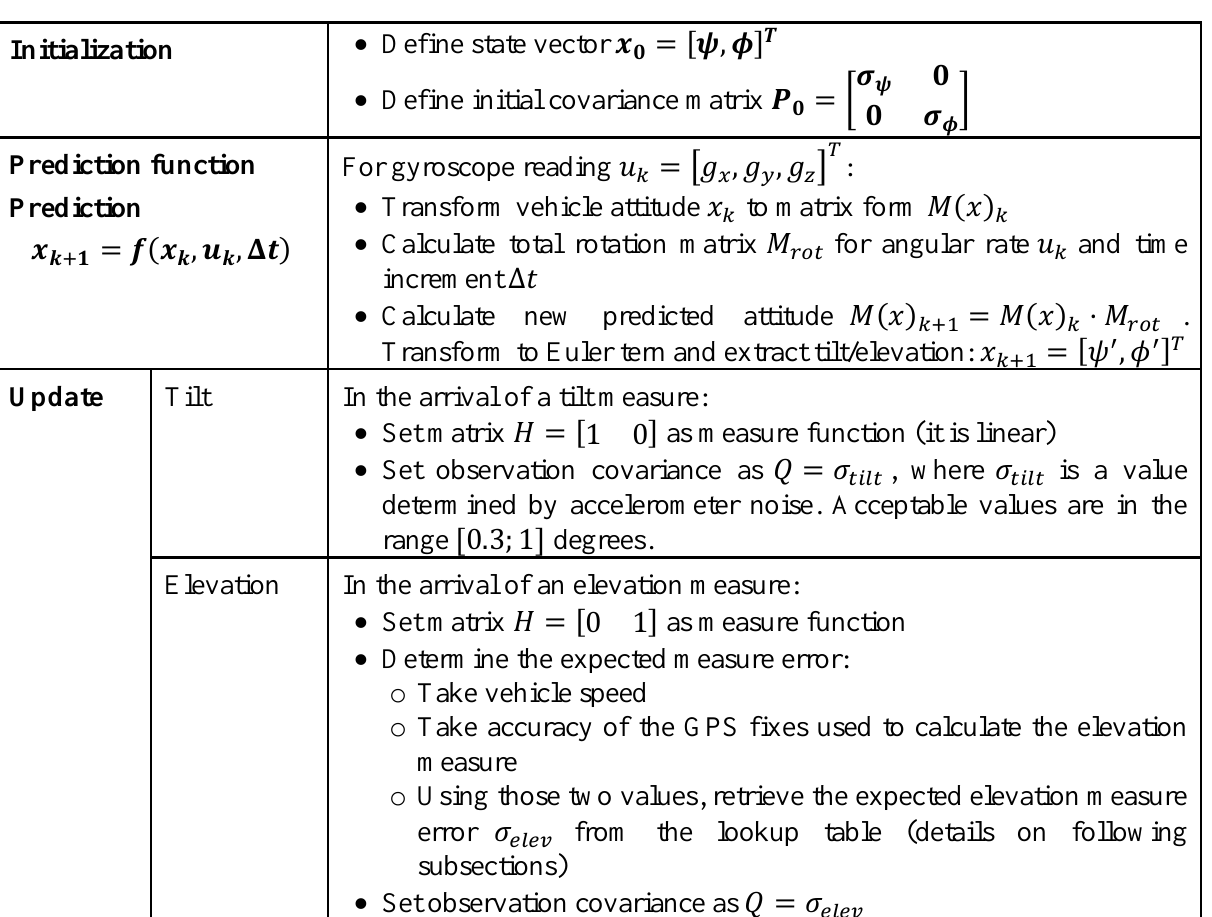
Table 1. Filtering algorithm for determining vehicle